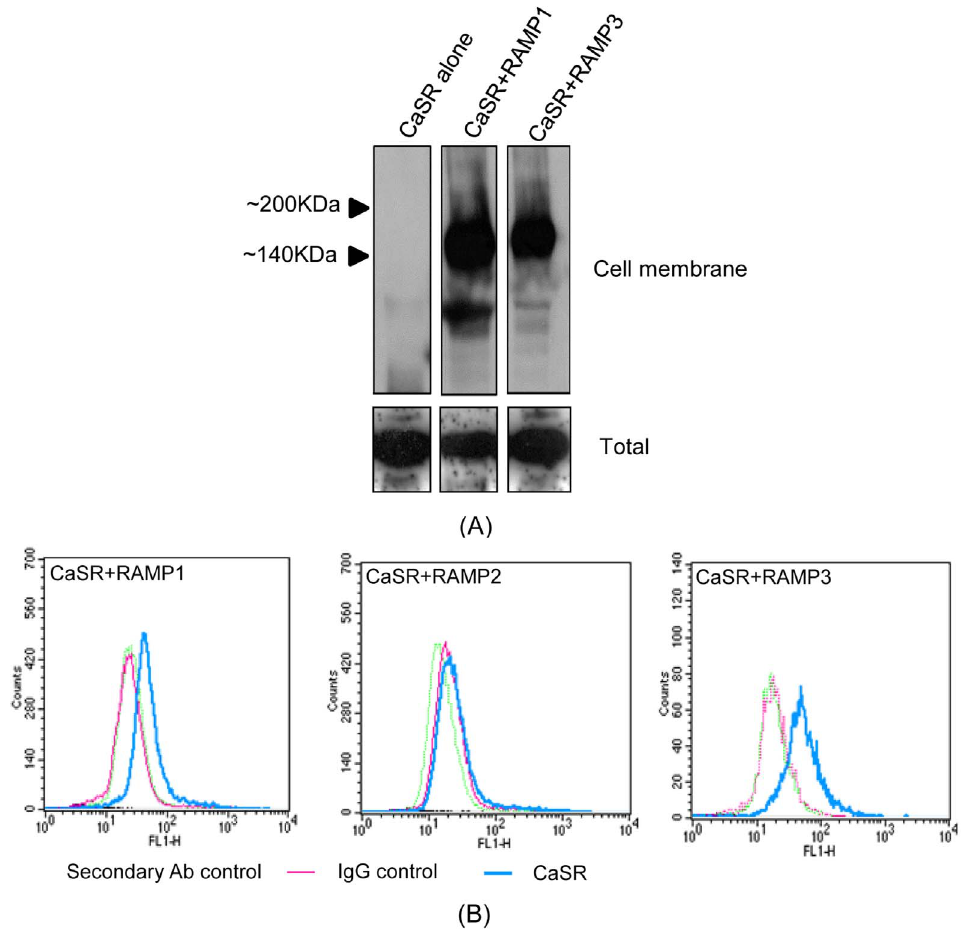
Figure 3. Cell surface expression of non-tagged CaSR. (A) Western blot of membrane and total cell lysate preparations from COS-7 cells transfected with CaSR alone (lane 1), CaSR and RAMP1 (lane 2), and CaSR and RAMP3 (lane 3), incubated with antibody to the CaSR, demonstrating the ability of RAMPs 1 and 3 to traffic the CaSR to the cell surface. (B) FACS analyses of non-permeabilised COS-7 cells expressing CaSR with either RAMPs 1, 2 or 3 showing shift from the IgG control in number of cells with surface fluorescence in RAMP1 and RAMP3 expressing cells, but not RAMP2 expressing cells.